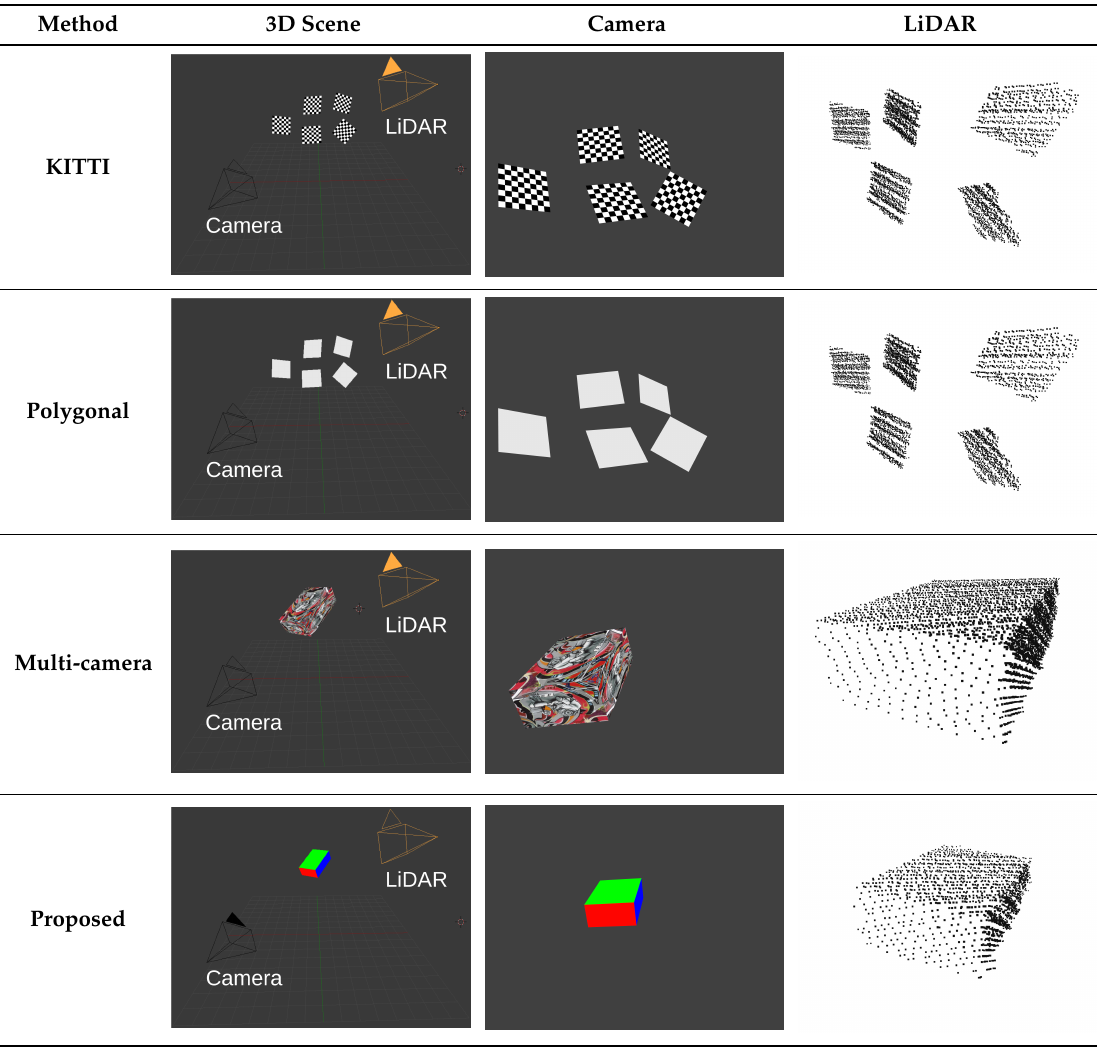
Table 3. Virtual calibration scenes used for the synthetic tests. Plots from left to right: (i) the 3D scene inside Blensor; (ii) a camera image and (iii) the LiDAR point cloud contaminated by zero-mean Gaussian noise with a 0.02 standard